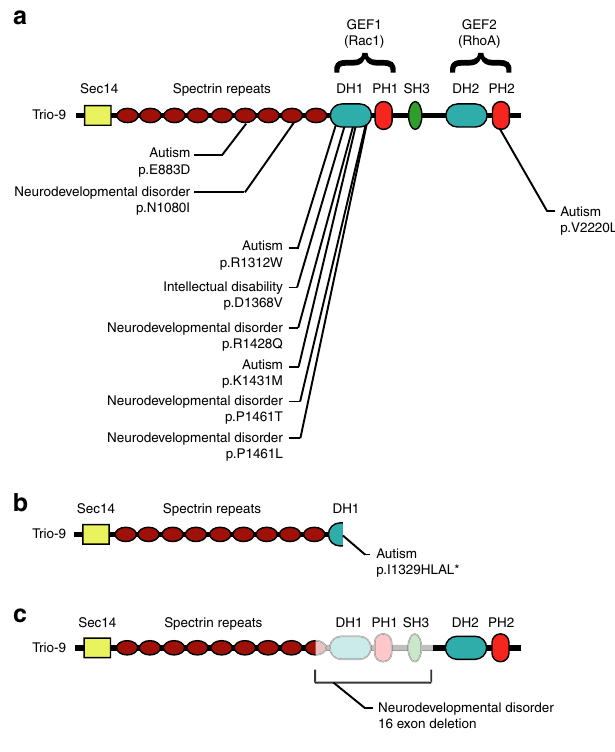
Fig. 1 ASD-related de novo mutations in Trio. a Missense, b nonsense and c copy number variation mutations in Trio found in individuals with ASD- related disorders. The different protein domains are indicated, starting with the N-terminus: Sec14 domain, Spectrin repeats, GEF1 domain (composed of a Dbl homology domain (DH1) and a Pleckstrin homology domain (PH1)), Src homology 3 domain (SH3), and the GEF2 domain (composed of a Dbl homology domain (DH2) and a Pleckstrin homology domain (PH2)). For each mutation, the individual ’ s diagnosis is given along with information about the alteration of Trio ’ s amino acid sequence. Position of amino-acid mutations from